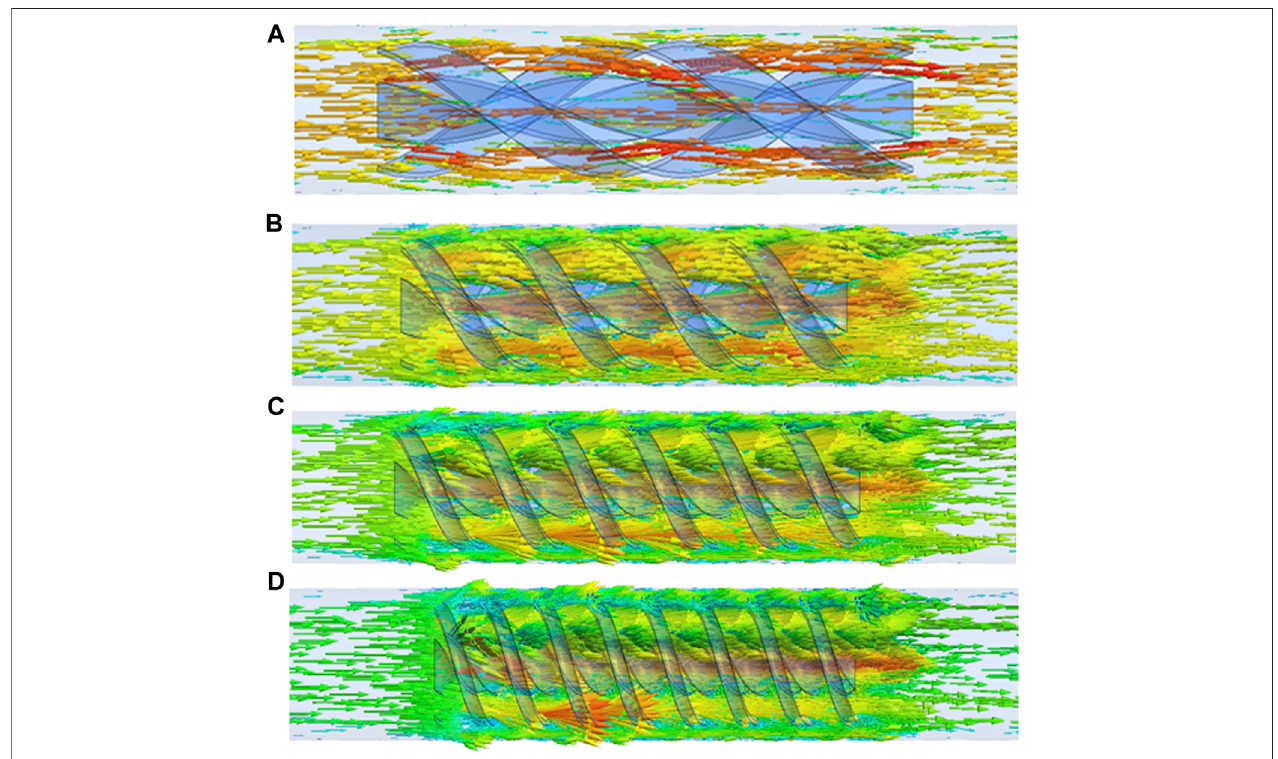
FIGURE 8 | The vectors of fl ow at Re (cid:1) 18,000, φ (cid:1) 3%, and torsion ratios of (A) n (cid:1) 1, (B) n (cid:1) 2, (C) n (cid:1) 3, and (D) n (cid:1) 4.